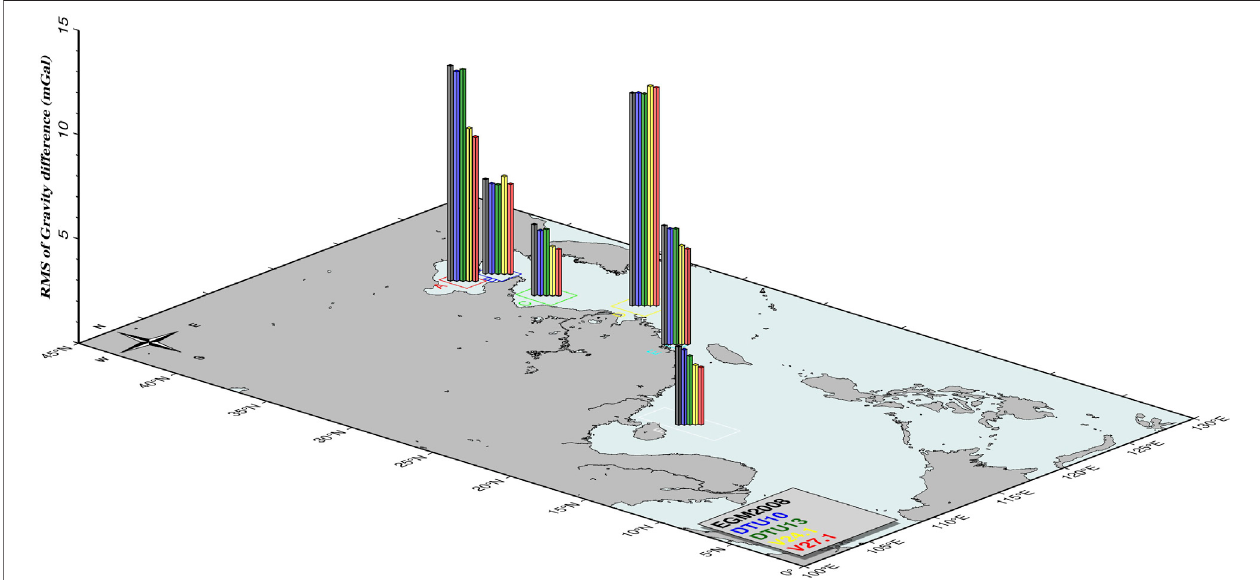
FIGURE 4 | 3D bar graph of RMSs between marine gravity models and shipboard gravity in coastal region of China. The black bar is RMS deviation between EGM2008and shipboard gravity, and theblue, dark green, yellow, and red bar are theRMS deviation forDTU10, DTU13, V24.1, and V27.1, respectively.From northto south, the red, blue, green, yellow, cyan, and white rectangle represent the areas A – F, respectively.